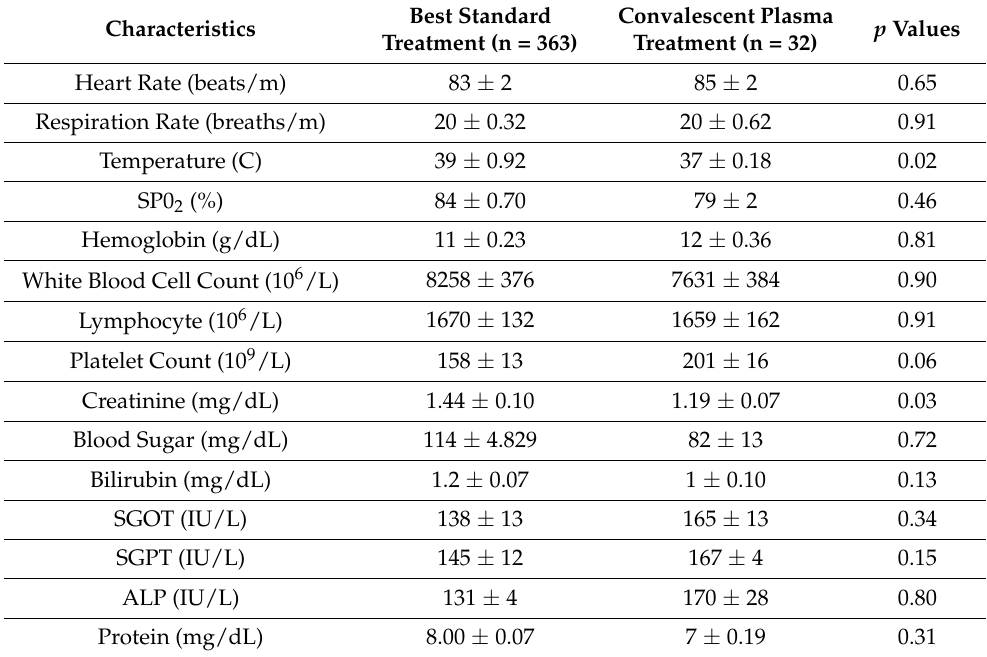
Table 2. Baseline biochemical characteristics of critically ill COVID-19 patients of best standard treatment group (n = 363) and convalescent plasma treatment group (n = 32).